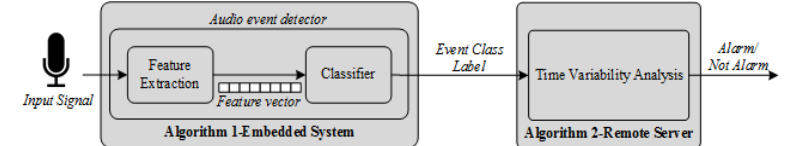
Figure 3. Block diagram of the algorithm proposed and where those algorithm will be